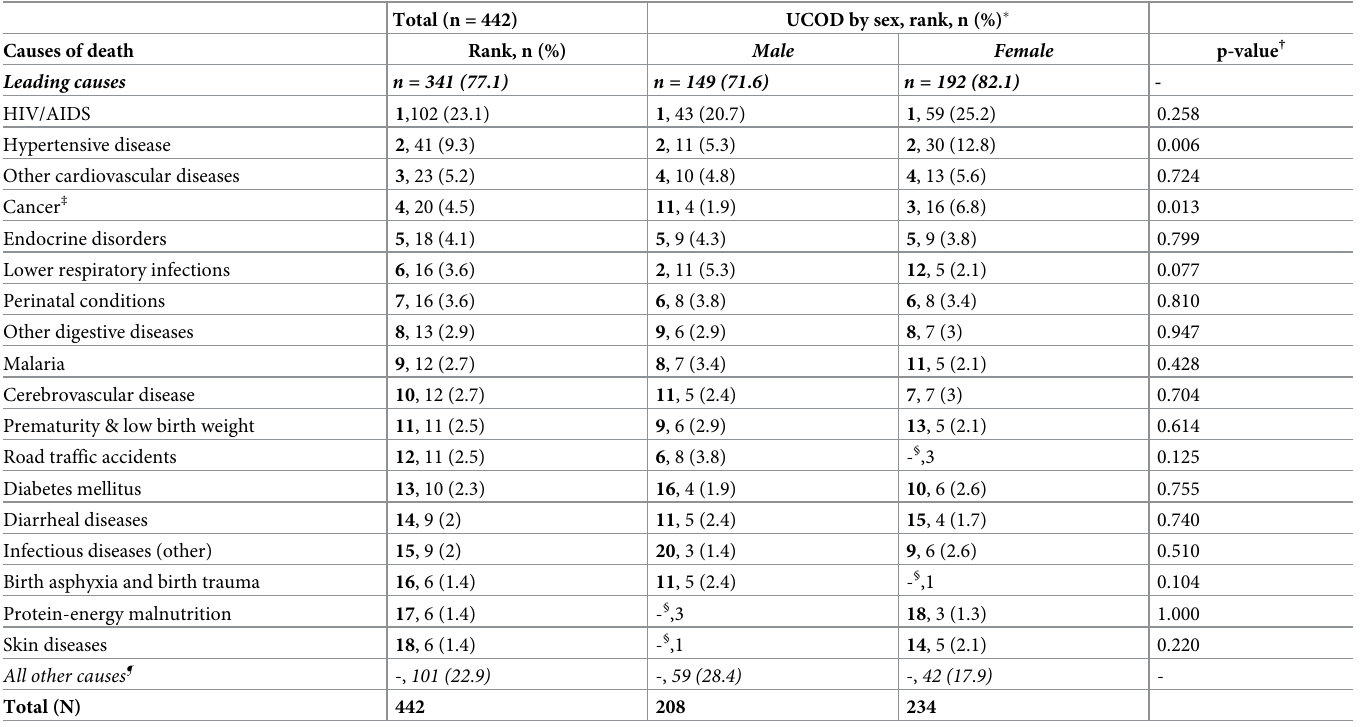
Table 2. Ascertained leading causes of death at two large hospitals and among all persons and sex, Kisumu County, Kenya (2019). Total (n = 442)